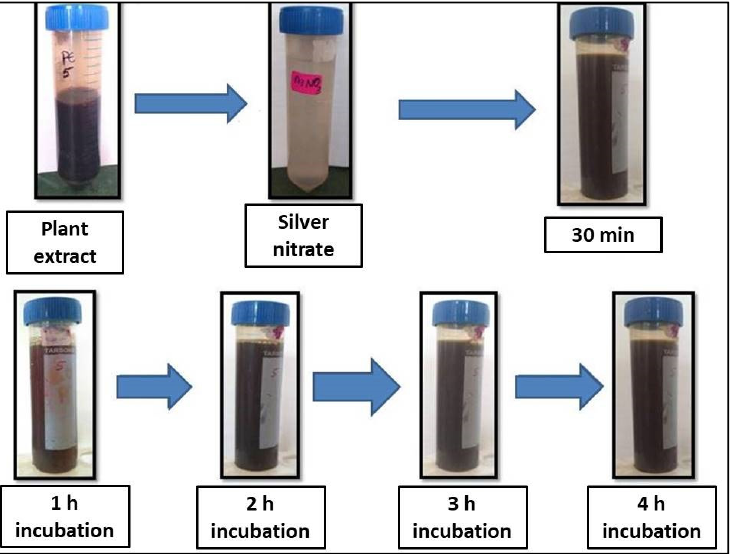
Figure 1. Formation of silver nanoparticles after adding aqueous leaf extract of R. apiculata with the change in time.